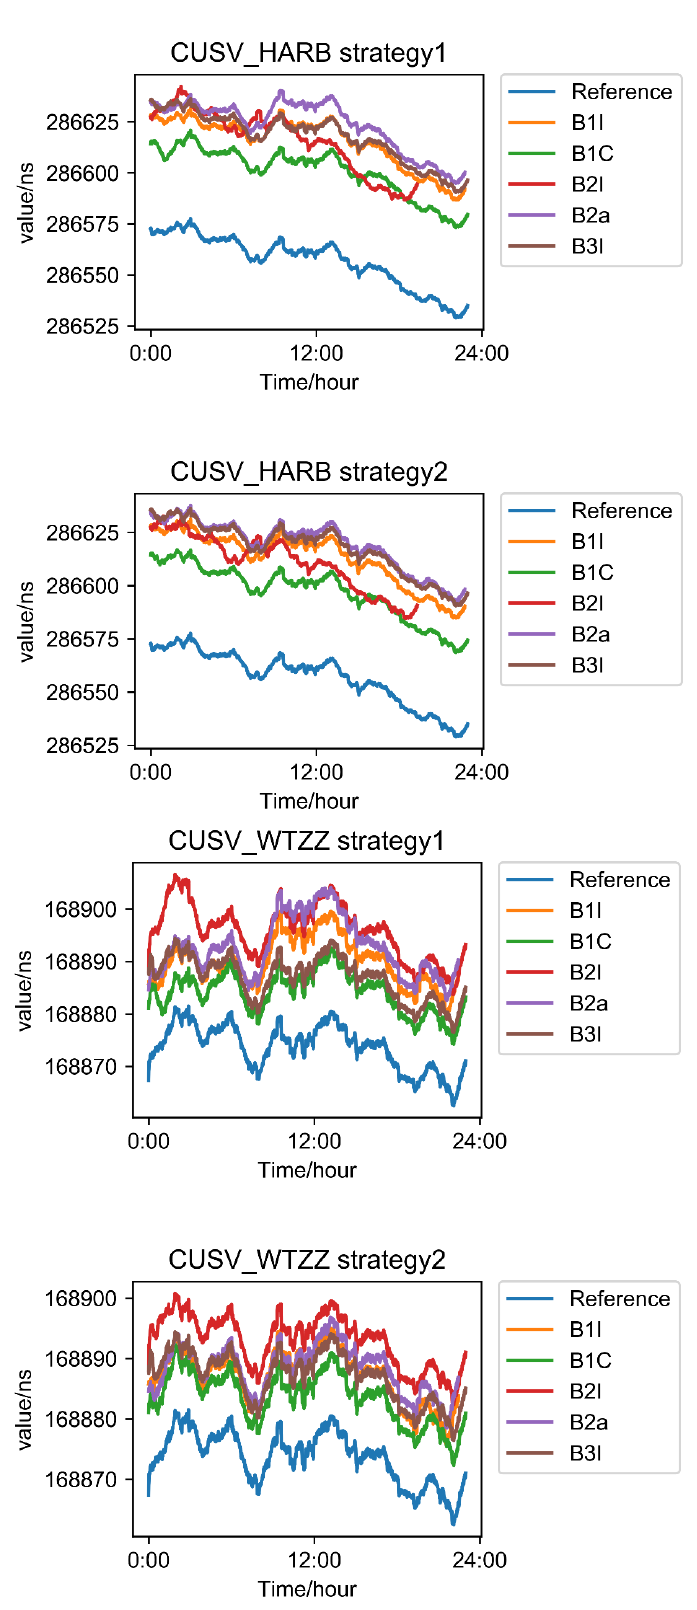
Figure 12. The time sequence diagram of two time links, two strategies, and five frequency points. Taking the ionosphere-free dual-frequency results of B1I and B3I as a reference, the to obtain the STD in Figure 13.